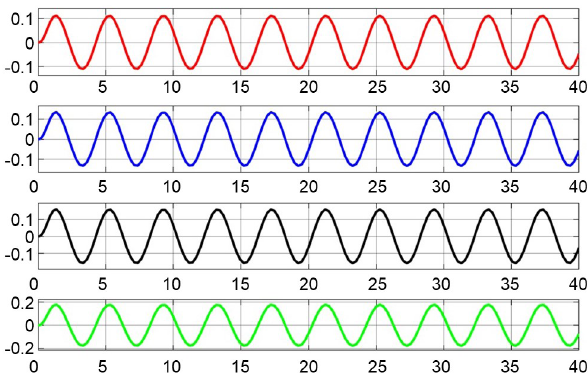
Figure 16. Influence of wave period on the position of the float. (The wave periods from top to bottom are 2, 4, 6 and